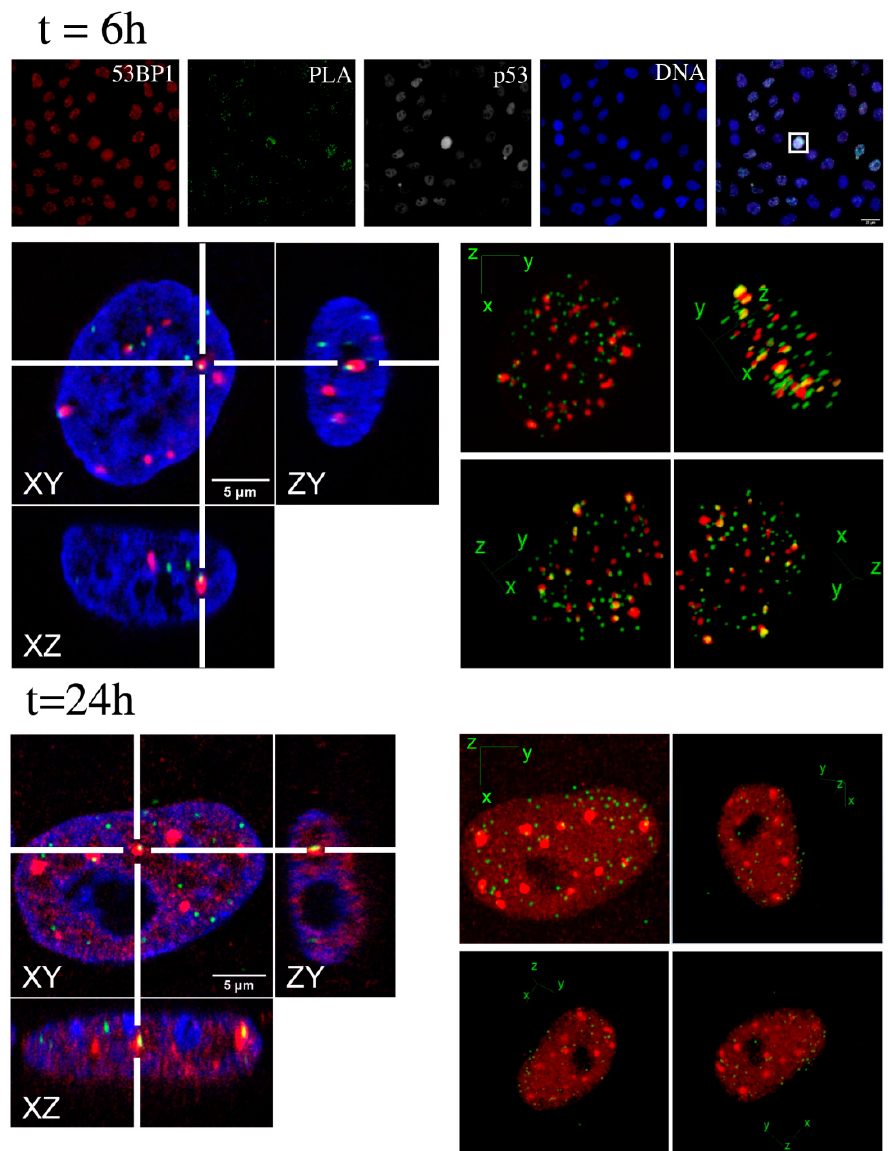
Figure 6. Three-dimensional high-resolution confocal microscopy of 53BP1-p53 putative complex. Samples stained for the detection of 53BP1–p53 PLA spots were analyzed according to the described image cytometry procedure to select a PLA-enriched high-p53 expression phenotype. Cells were relocated (an exemplificative cell of interest is reported (white square) in the widefield images in the upper row; scale bar, 25 microns) to perform the high-resolution 3D analysis in confocal imaging. Pictures show conventional and lateral views of a selected slice (left) and 3D maximum intensity projections from different angles (right) at the indicated time-points for a representative cell.